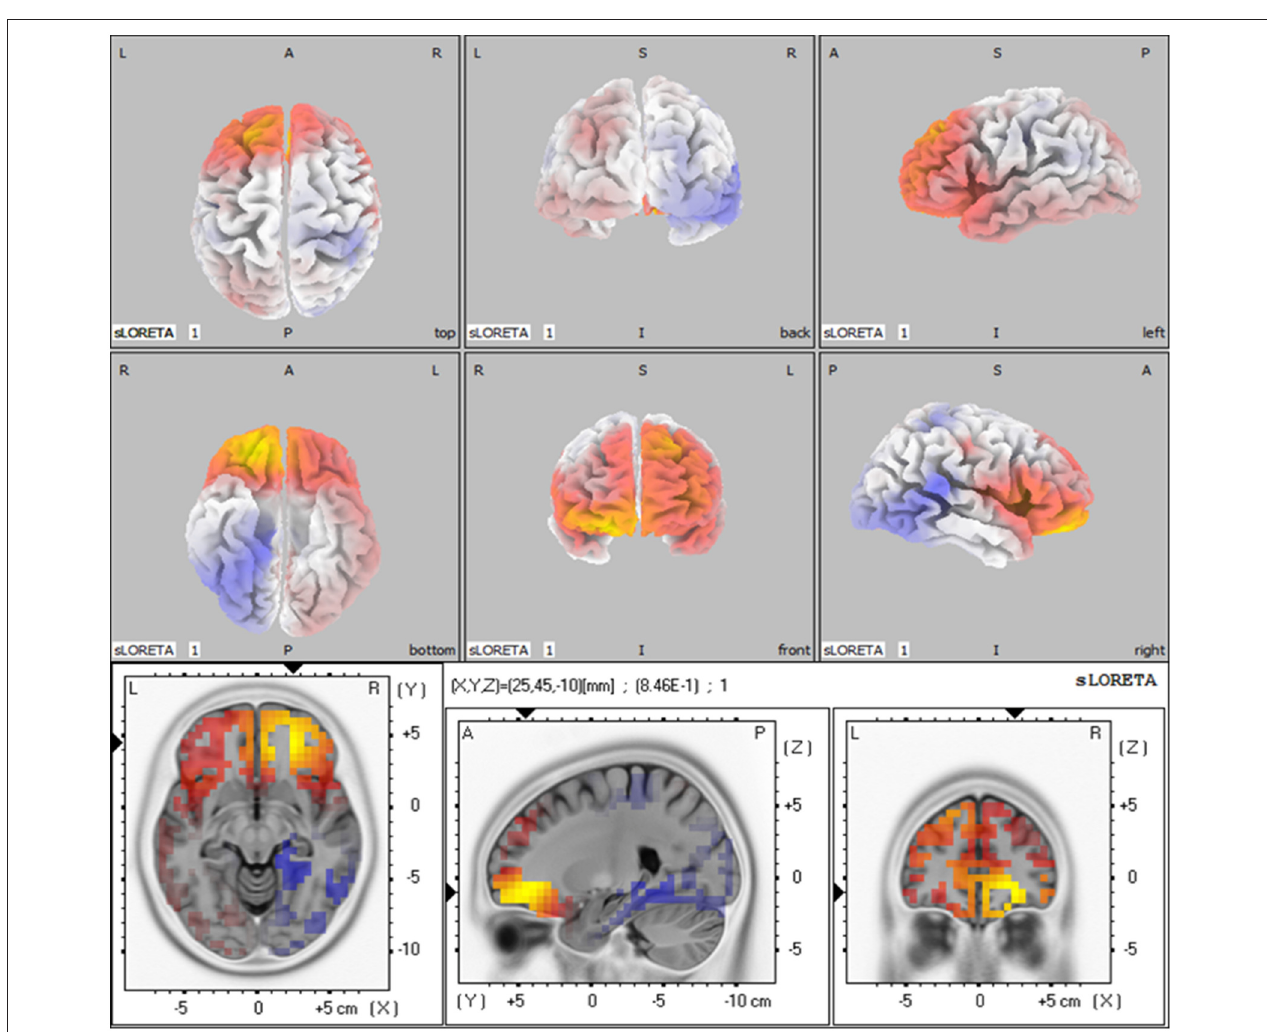
FIGURE 5 | The sLORETA images showing statistical differences between aMCI and control group (3D-view and slice-view) in the P2 time-range. The three slice-view images below located the maximal difference between aMCI group and control group (MNI coordinates x , y , z = 25, 45, − 10). Positive difference was in yellow color with reference of MCI